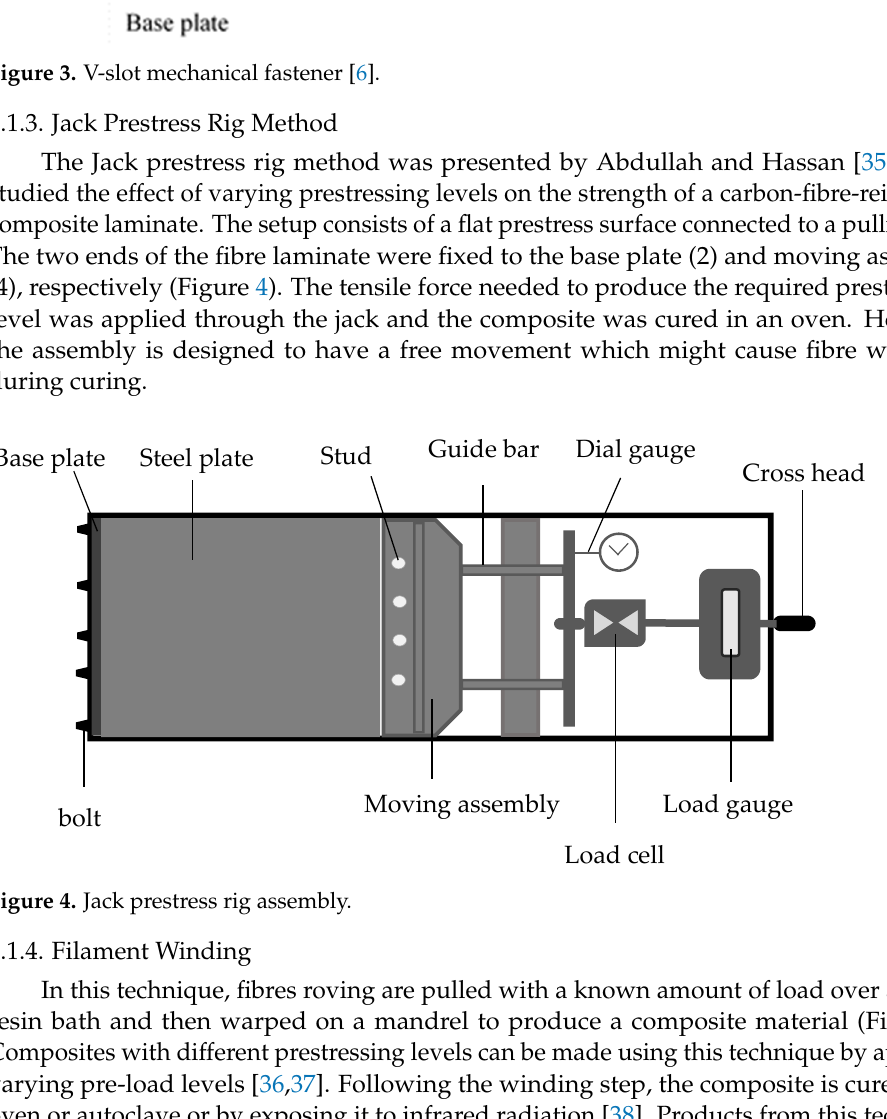
Figure 4. Jack prestress rig assembly.